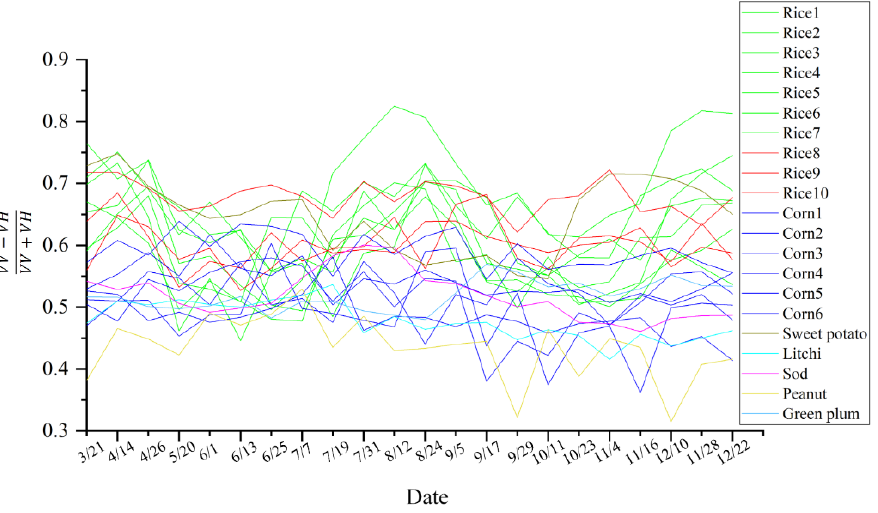
Figure 5. Crop time series of VV − VH for 21 field survey areas. (A total of seven crops, respectively, rice, corn, sweet potato, litchi, sod, peanut, green plum).